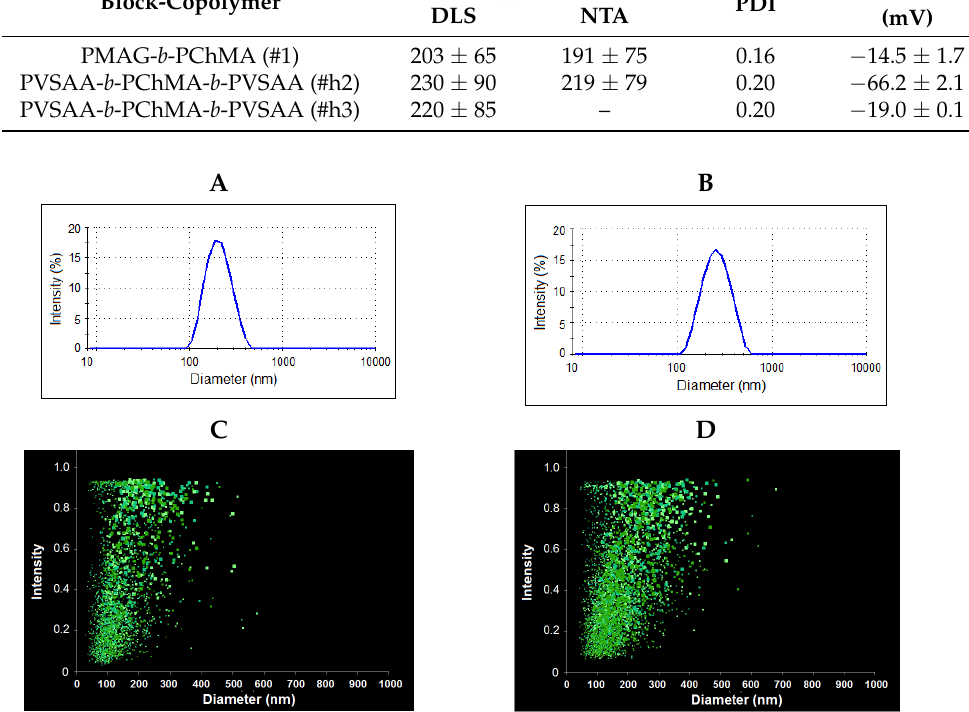
Figure 9. Results of dynamic light scattering ( A , B ) and nanoparticle tracking analysis ( C , D ) for PMAG- b -PChMA ( A , C ) and PVSAA- b -PChMA- b -PVSAA ( B , D